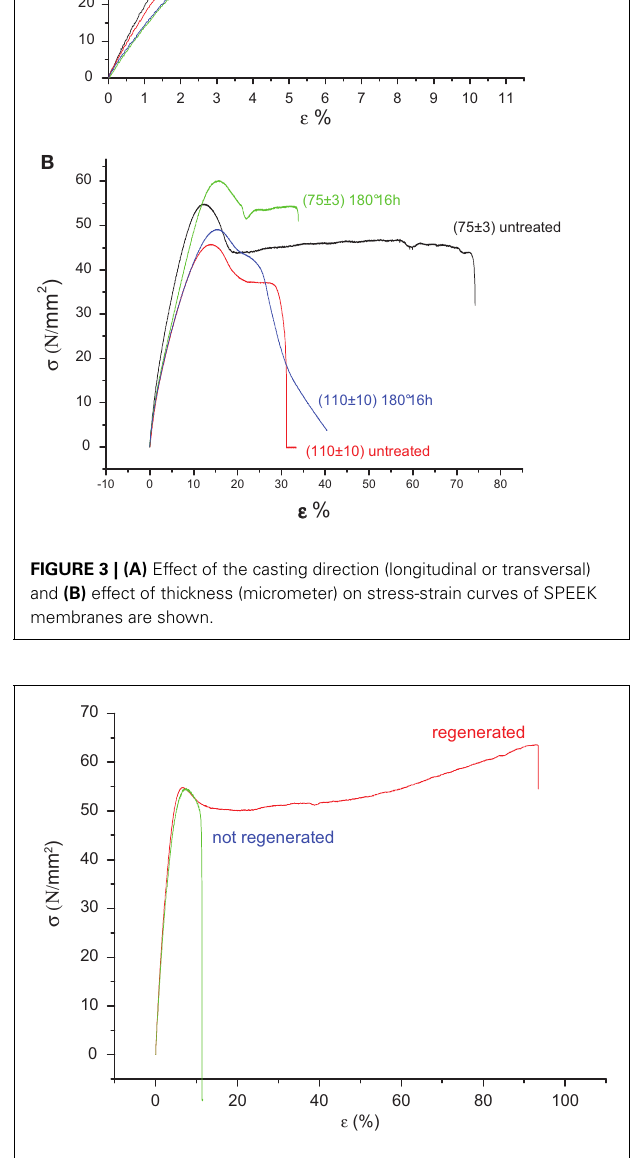
FIGURE 4 | Regeneration in 5M H 2 SO 4 for a SPEEK sample treated for 16h at 180°C is shown .